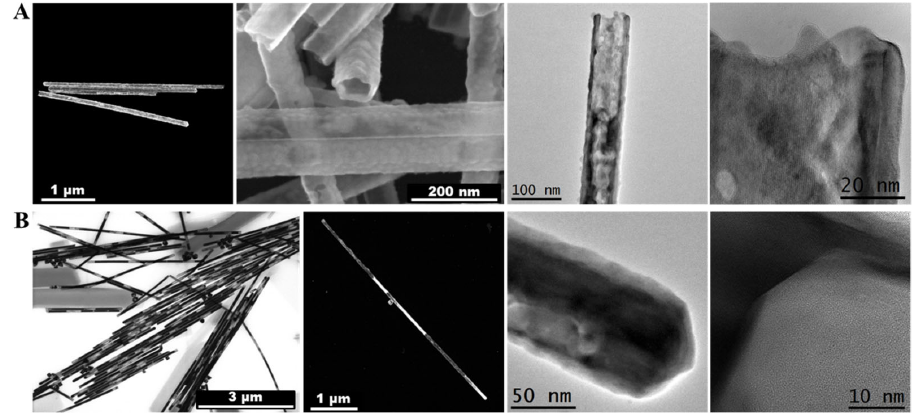
Figure 1 . Microstructure of AuAg nanotubes. ( A ) HAADF ‐ STEM, SEM, TEM, and HRTEM micro ‐ graphs of the hollow nanotubes, respectively. ( B ) BF ‐ STEM, HAADF ‐ STEM, TEM, and HRTEM mi ‐ crographs of the hybrid nanotubes, respectively.